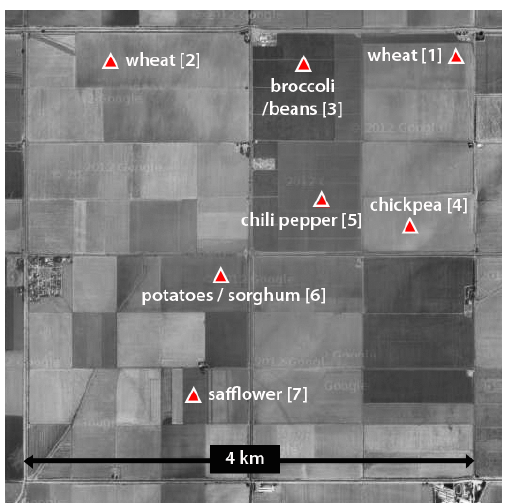
Fig. 3. Satellite view of the studied zone with respective positions of the EC stations (Imagerie © 2012 Cnes/Spot Image, DigitalGlobe, Données cartographiques © 2012 Google,